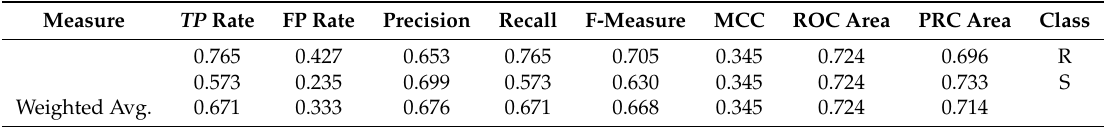
Table 7. Detailed accuracy by class of J48 (10-fold cross-validation).